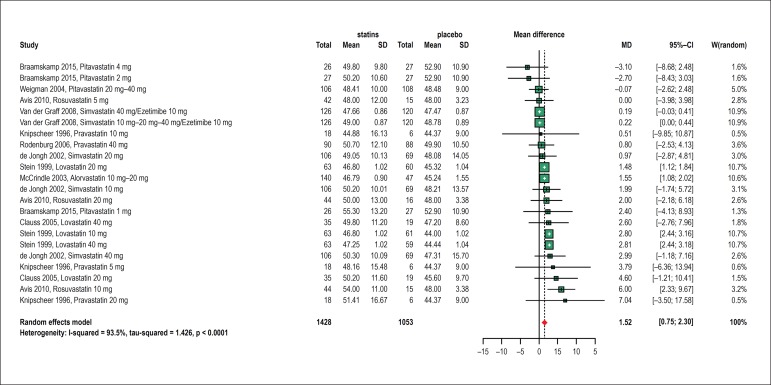
Forest plots showing the effect of statin therapy on high-density
lipoprotein (HDL) cholesterol levels.